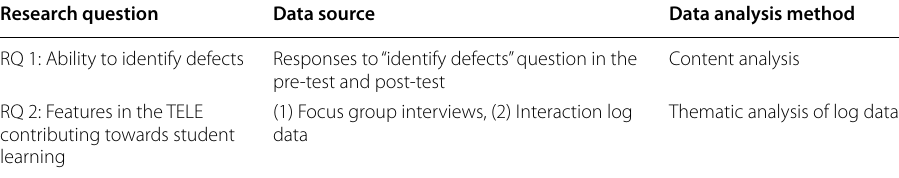
Table 2 Summary of the research questions, their corresponding data source, and analysis method Research